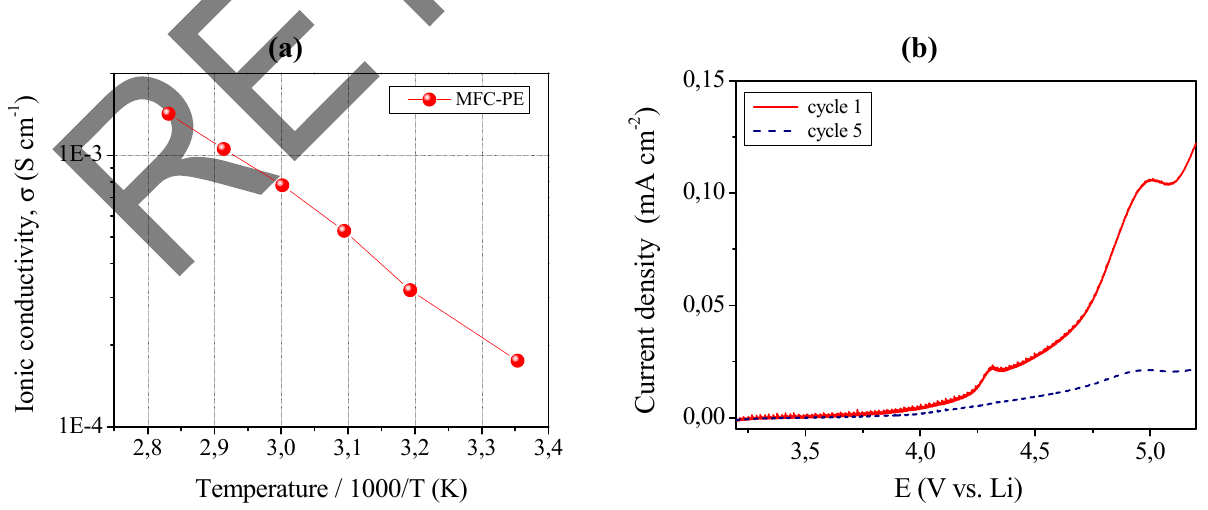
Figure 10. ( a ) Conductivity versus temperature plot of the MFC-PE reinforced quasi-solid polymer electrolyte. Data obtained by impedance spectroscopy; ( b ) Current vs . voltage curves at ambient temperature for